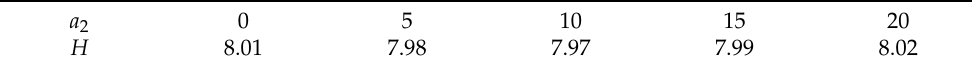
Table 1. Image entropy H and a corresponding polynomial coefficient a 2